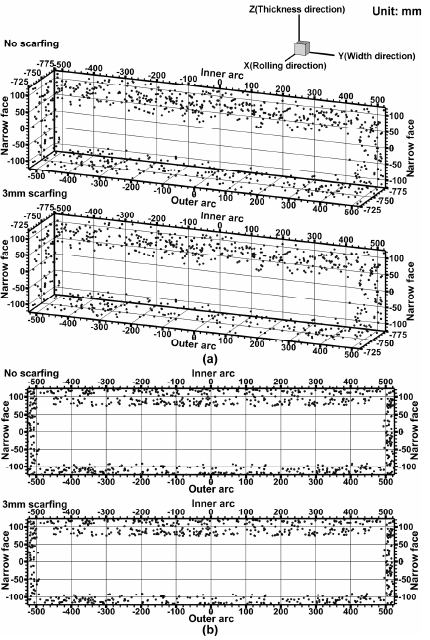
Figure 4. The initial positions of inclusions in the CC slab: 3D ( a ) and 2D ( b ) distributions.